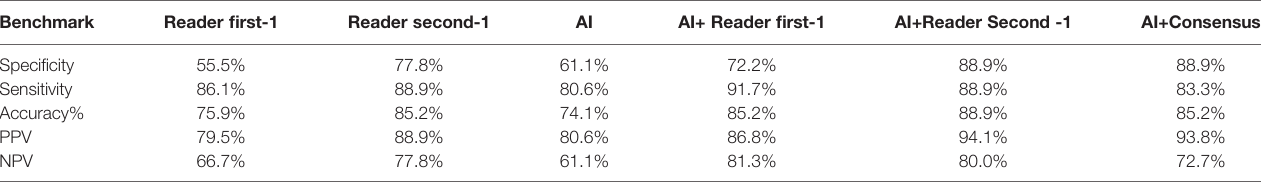
TABLE 5 | Screening performance benchmarks for arti fi cial intelligence algorithms and for radiologists among the 36 patients who received a diagnosis of malignant AD and 18 women who received a diagnosis of benign AD.